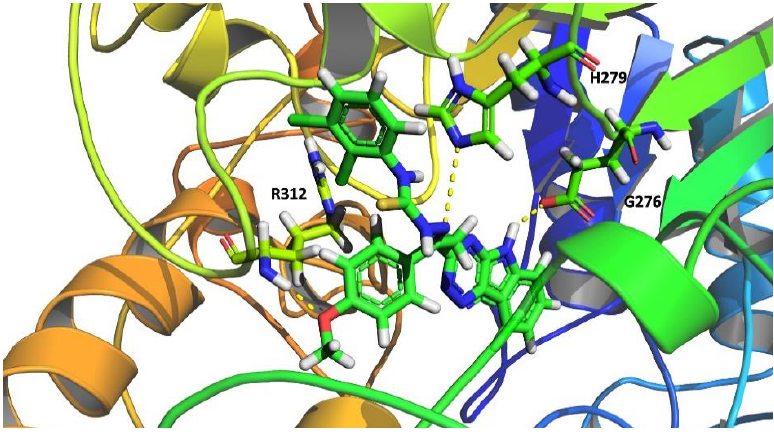
Figure 3. Docking position of compound 1 in the active site of the α-glucosidase enzyme .